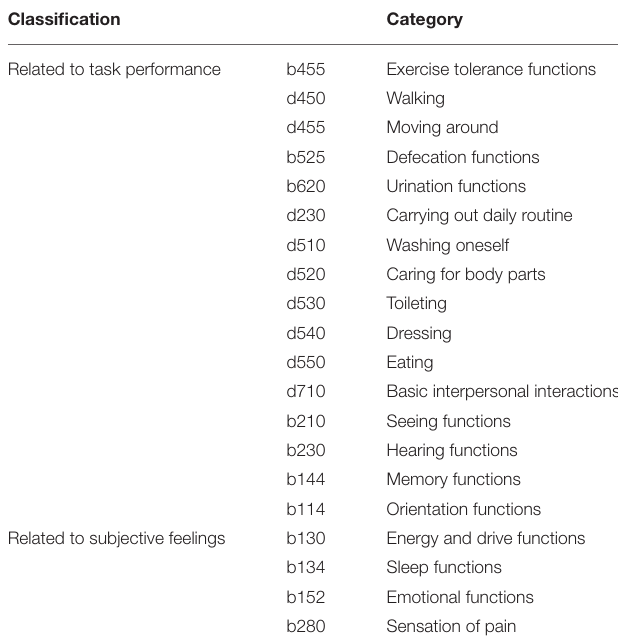
TABLE 1 | The selected 20 ICF